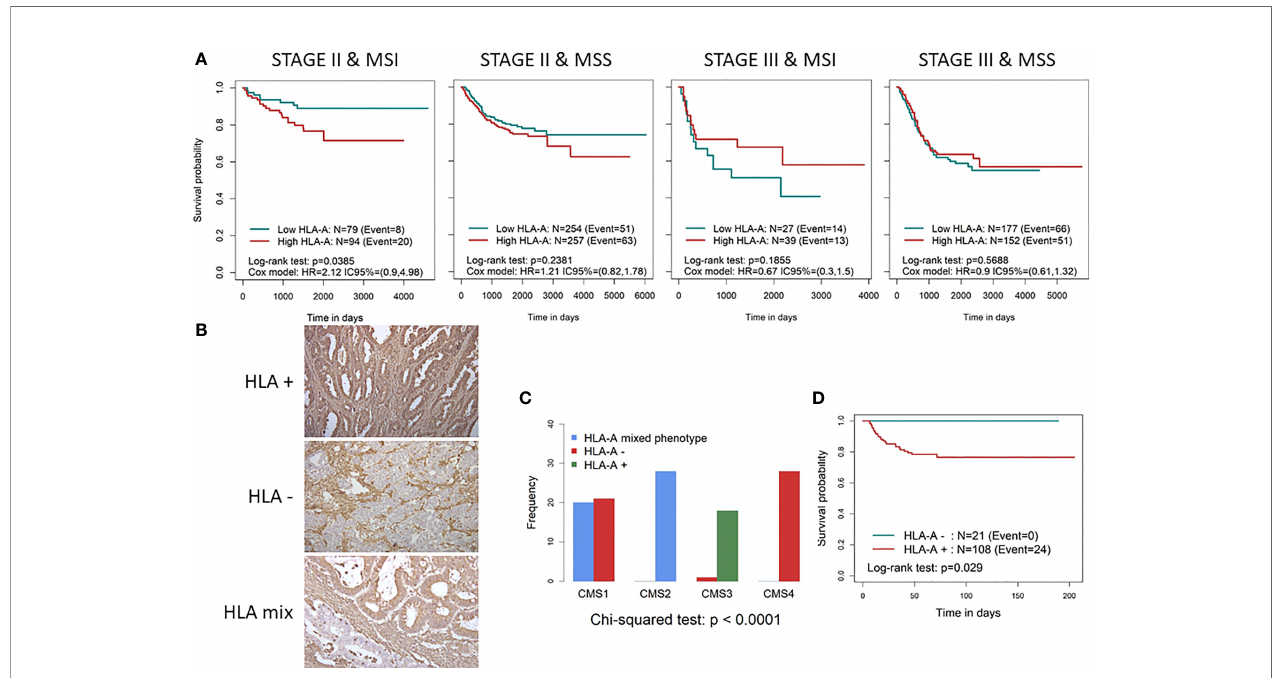
FIGURE 1 | Characterisation of HLA-A expression as a prognostic biomarker in CRC patients. (A) Kaplan – Meier curves divided into high and low HLA-A categories in different CRC subtypes according to early/late stage and MSS/MSI status strati fi cation. To de fi ne low (green line) and high (red line) HLA-A categories, the median gene expression was used as cutoff, in each dataset. p-Values were calculated using the binary Log-rank test and by fi tting a Cox proportional hazards regression model stratifying by study and adjusted for age, sex, and stroma. (B) IHC staining of representative slides of tumours losing (total and partial) HLA expression (HLA − ), tumours with HLA on surface (HLA + ) and with a mixed phenotype (only part of the tumour with HLA lost). (C) Bar diagram showing the distribution of HLA − (red), HLA mix (blue), and HLA + (green) across the 4 CMS subtypes. (D) Kaplan – Meier curves divided into HLA − (red) and HLA + (blue) tumours in stage II MSI patients. CRC, colorectal cancer; MSS, microsatellite stable; MSI, microsatellite instability; IHC, immunohistochemistry; CMS, consensus molecular